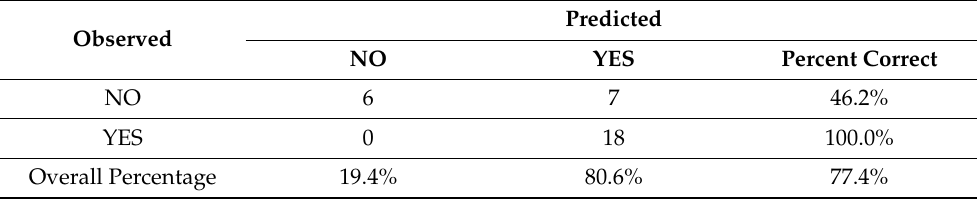
Table 7. Classification of participants in the decision tree analysis based in the threshold value of TNF- α